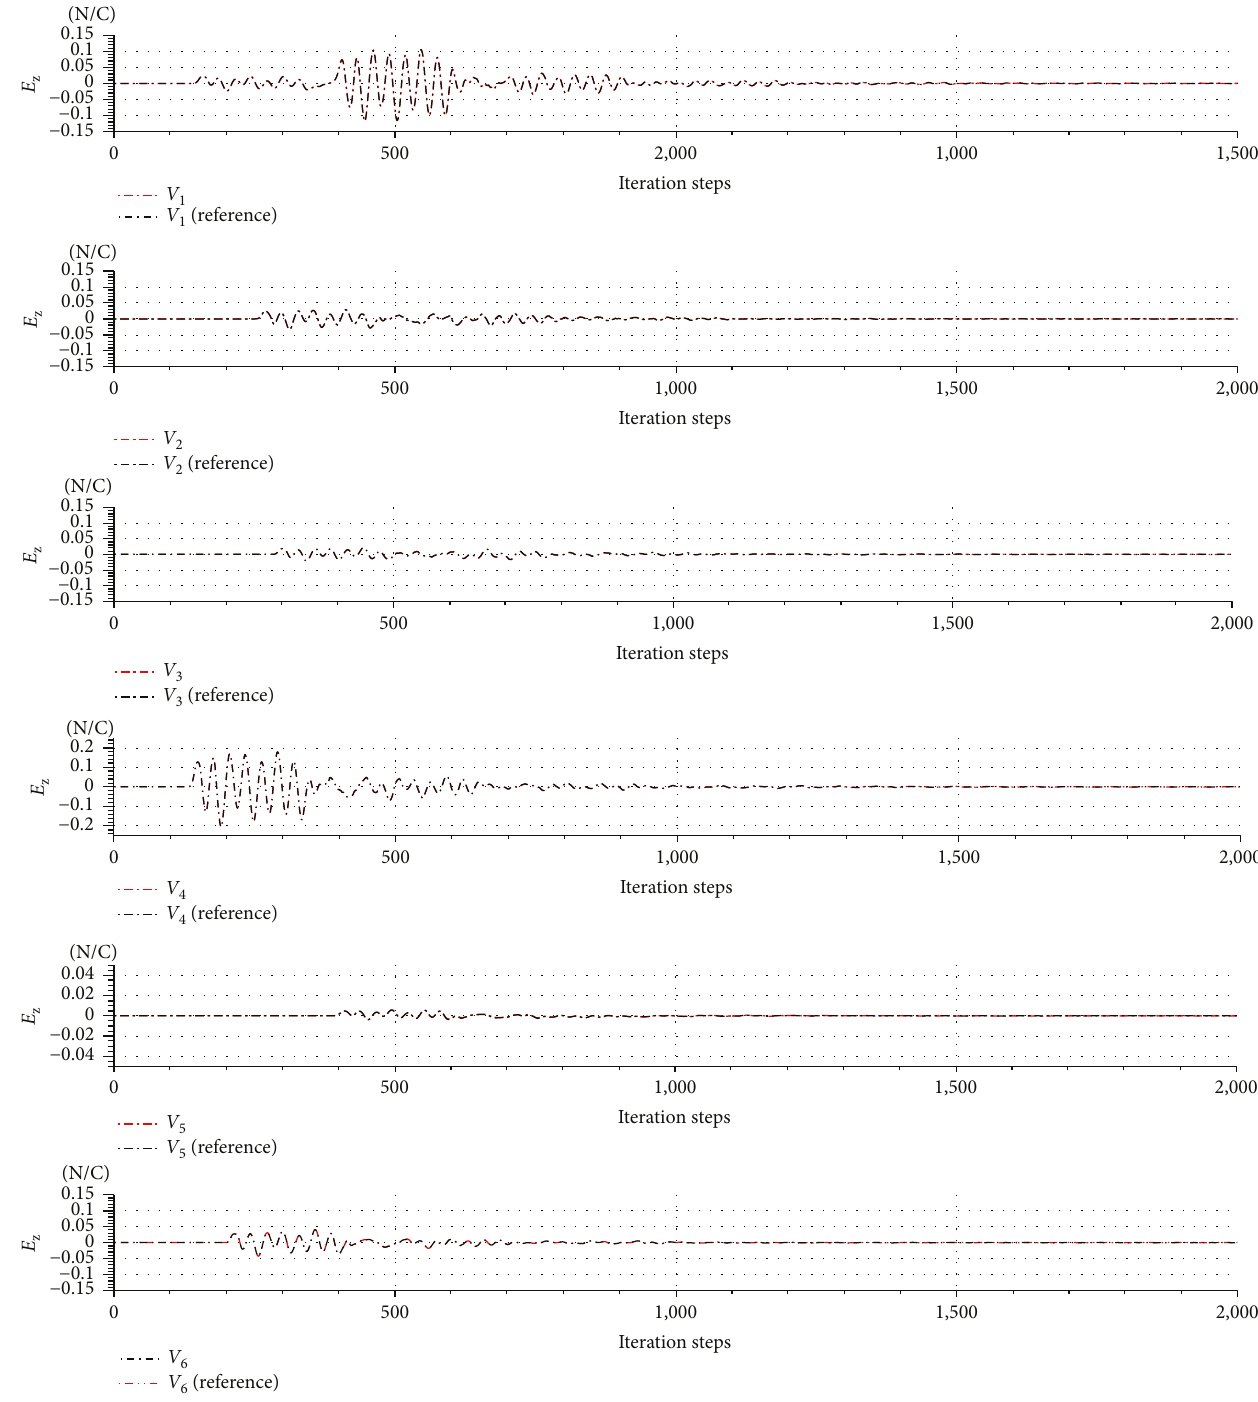
Figure 11: Behaviour of electromagnetic fi eld in the viewers of interest, for the parabolic plate experiment. No distinguishable di ff erence can be observed between the CPML and the reference solutions. We observe an excellent wave absorption without presenting spurious re fl ected waves. The simulation lasted for 1160 time steps, and the source was turned o ff at n = 580